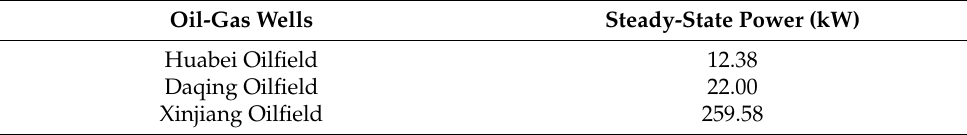
Table 6. Steady-state power of the three major oilfields.